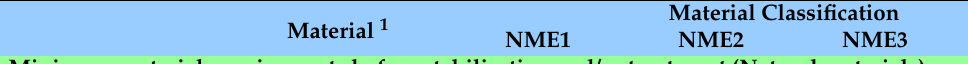
Table 1. Engineering requirements for different material classifications